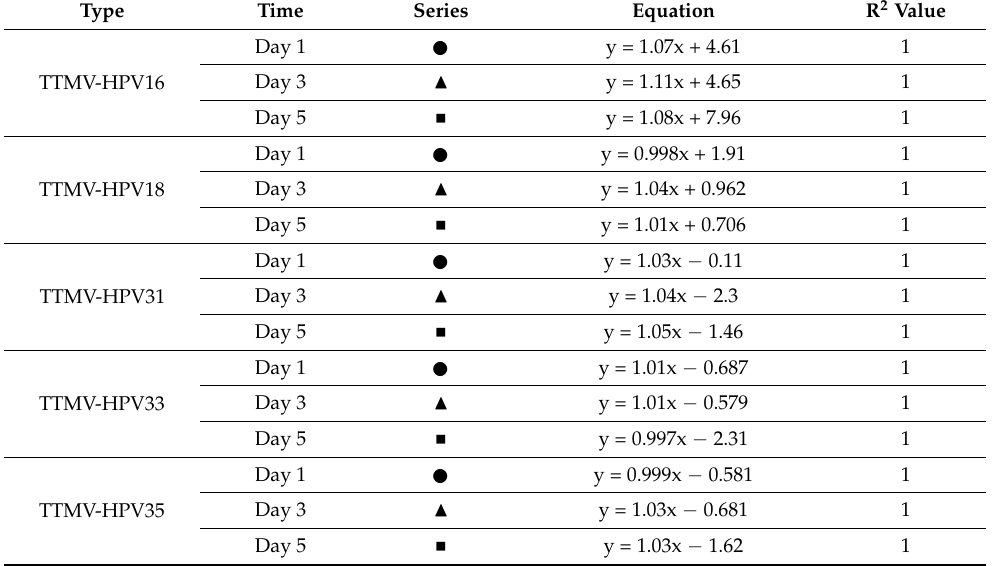
Table 5. Equations and coefficients of determination (R 2 values) for all types at days one, three and five. Corresponding linearity plots are given in Figure 1 above. Figure 1. Linearity plots for TTMV-HPV16, 18, 31, 33 and 35 DNA at six different concentrations on days one, three and five. Corresponding equations and R 2 values are given in Table 5 below.